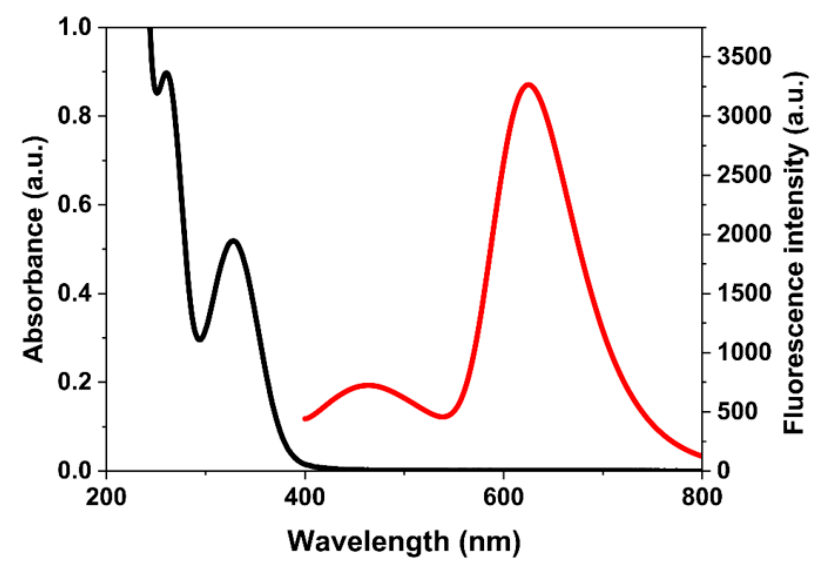
Figure 6. The UV–Vis absorption of ROX (black line) and fluorescence emission of APTES@Mn-ZnS QDs (red line).